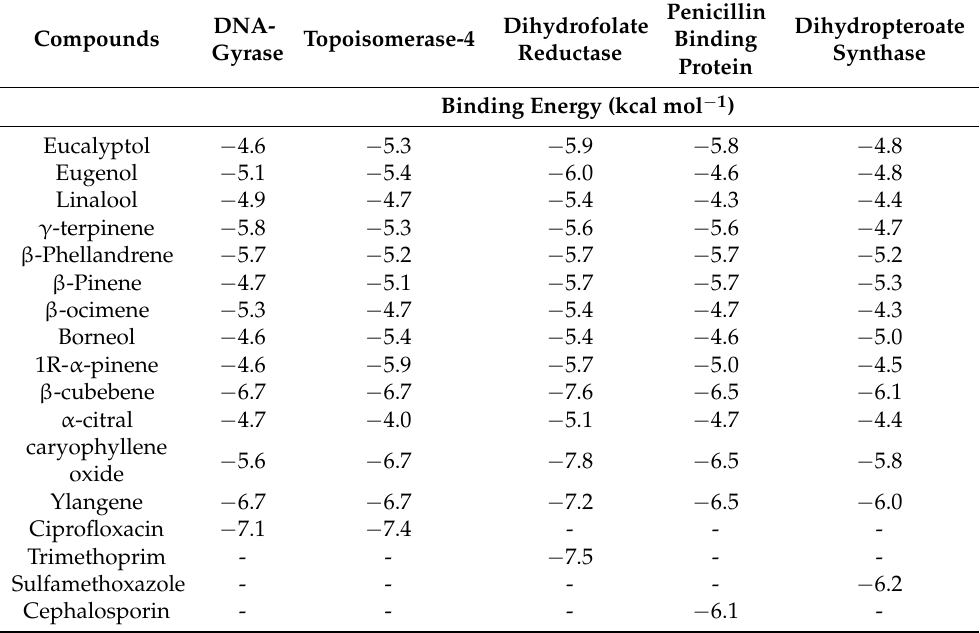
Table 3. Molecular docking/in-silico analysis illustrating the comparative binding energy (kcal mol − 1 ) for interaction of key metabolic enzymes of bacterial with phytoconstituents present in the EOs of three species of Ocimum and known antibiotics viz. ciprofloxacin, cephalosporin, trimethoprim and